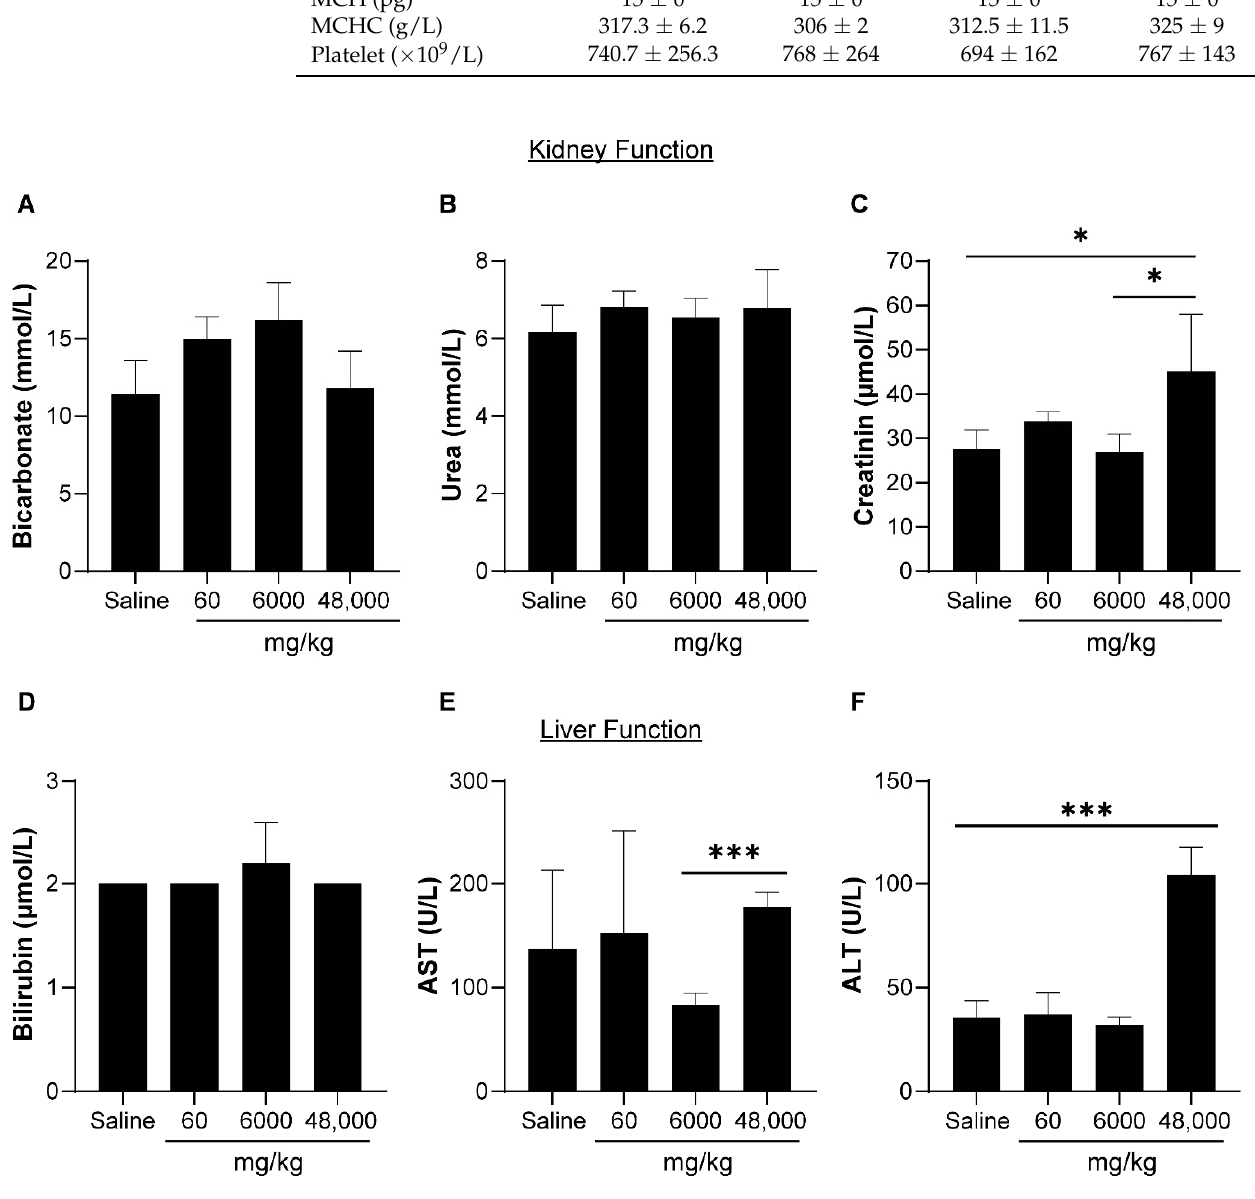
Figure 8. Effects of PPNs (repeated doses) on kidney and liver function. ( A ) Bicarbonate, ( B ) urea, ( C ) creatinine, ( D ) bilirubin, ( E ) AST, and ( F ) ALT levels in the mice plasma 14 days after the PPN (60 mg/kg, 6000 mg/kg and 48,000 mg/kg) or saline injections. The data represent the mean ± SEM of five mice and the statistical significance was determined using Tukey’s multiple comparison test (*** and * represent p < 0.001 and p <0.01, respectively). Table 4. Hematological parameters in BALB/c mice following 14 days of repeated IV administra- tion of the PPNs. The data are expressed as mean ± standard deviation ( n = 5).